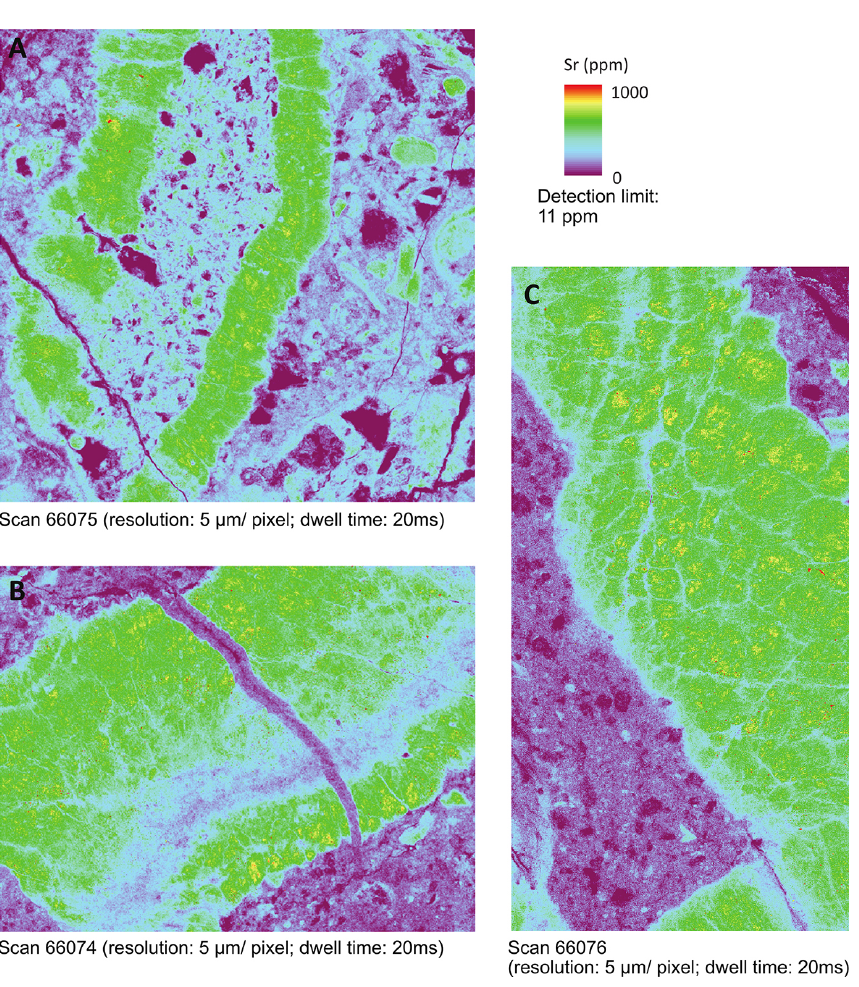
Figure B3. Fine scan of the investigation areas on sample 17NP436a for